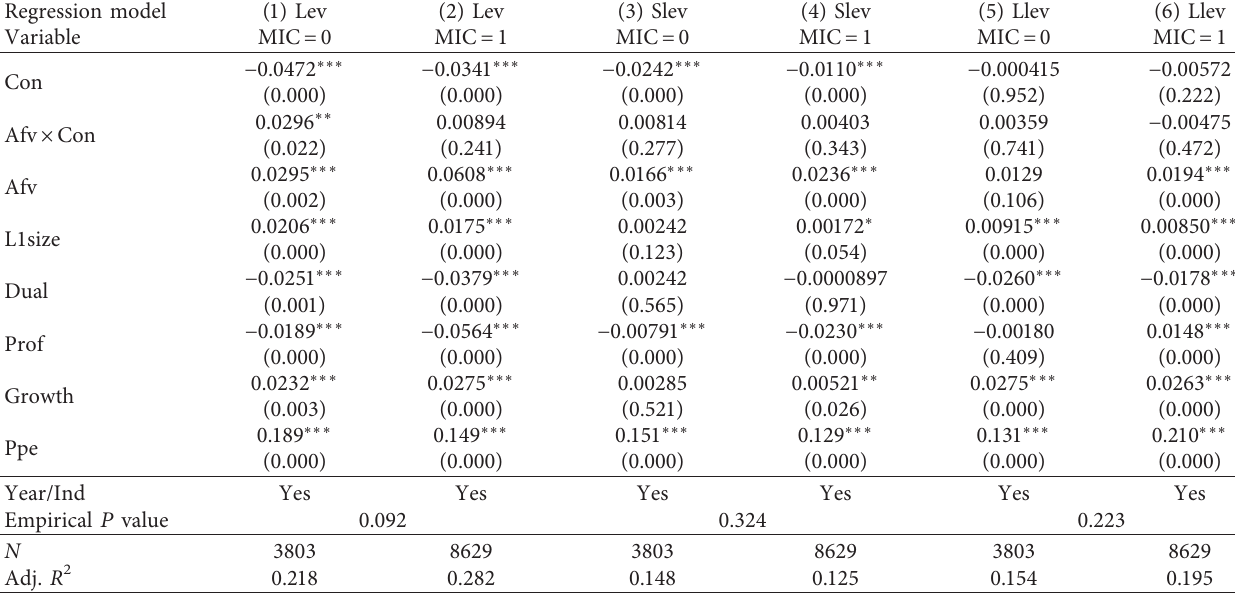
Table 6: The influence of internal control on the adjustment of fair value measurement.